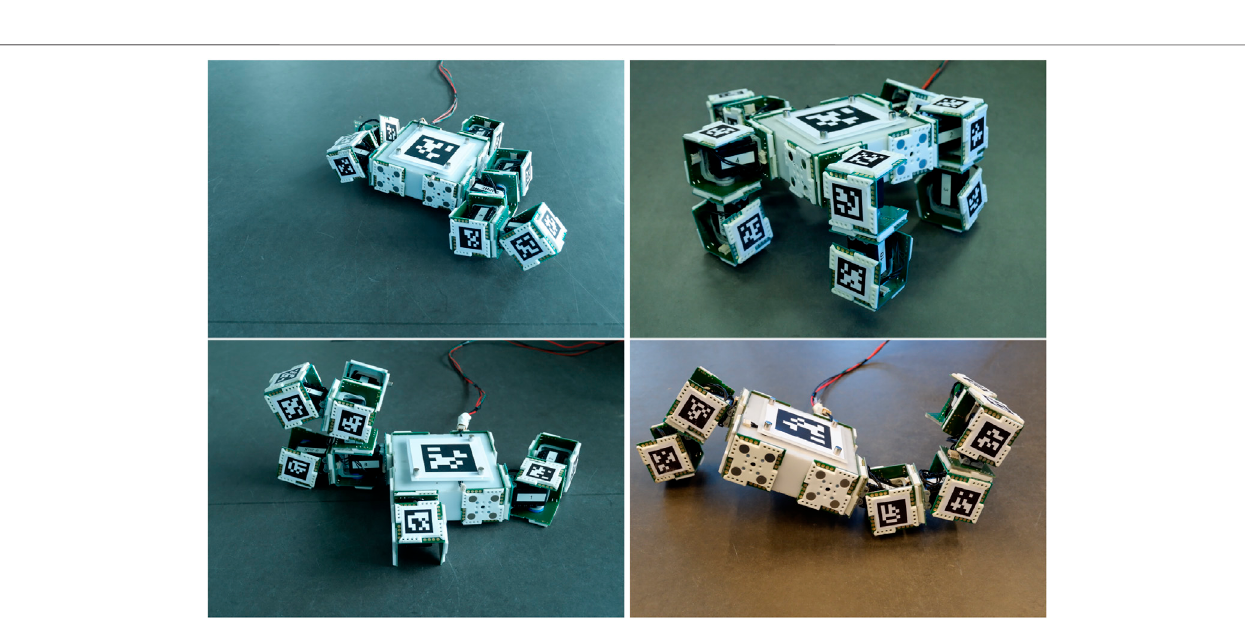
FIGURE6| SomeevolvedrobotsthatweremanuallybuiltwithEMERGEmoduleswiththehelpofthevisualguidingtool.Therobotsareshownwiththemotorofthe modules set at the initial angle in the evaluation, based on the evolved controllers. All robots took under 5 min to assemble.